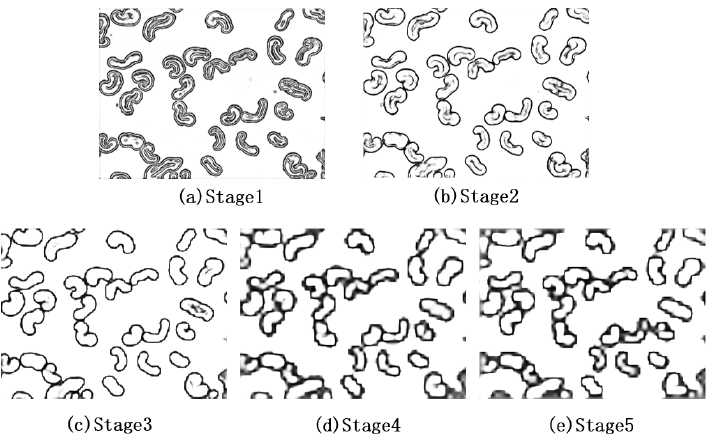
Figure 7. Output image of each stage in